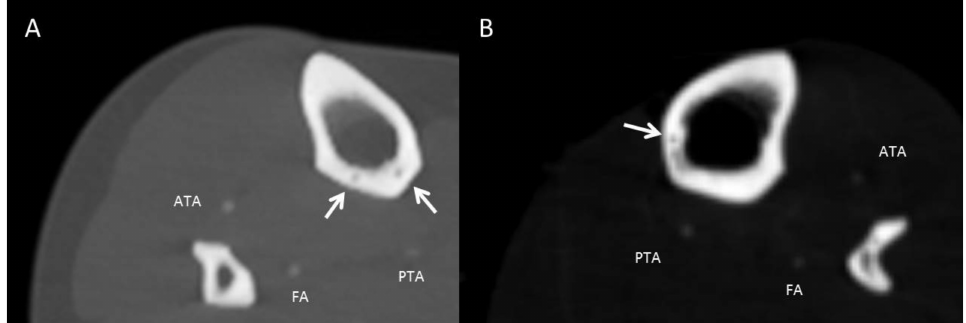
Figure 4. Axial reformatted images in bone window illustrating atypical number and topology of the TNAC. ( A ) Two canals traversing the posterior aspect of the tibia (two white arrows). ( B ) TNAC traversing the medial aspect of the tibia (white arrow). ATA: Anterior tibial artery. PTA: Posterior tibial artery. FA: Fibular